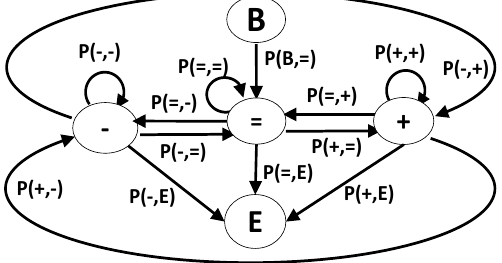
Figure 25. Automaton defining the possible game actions of the player